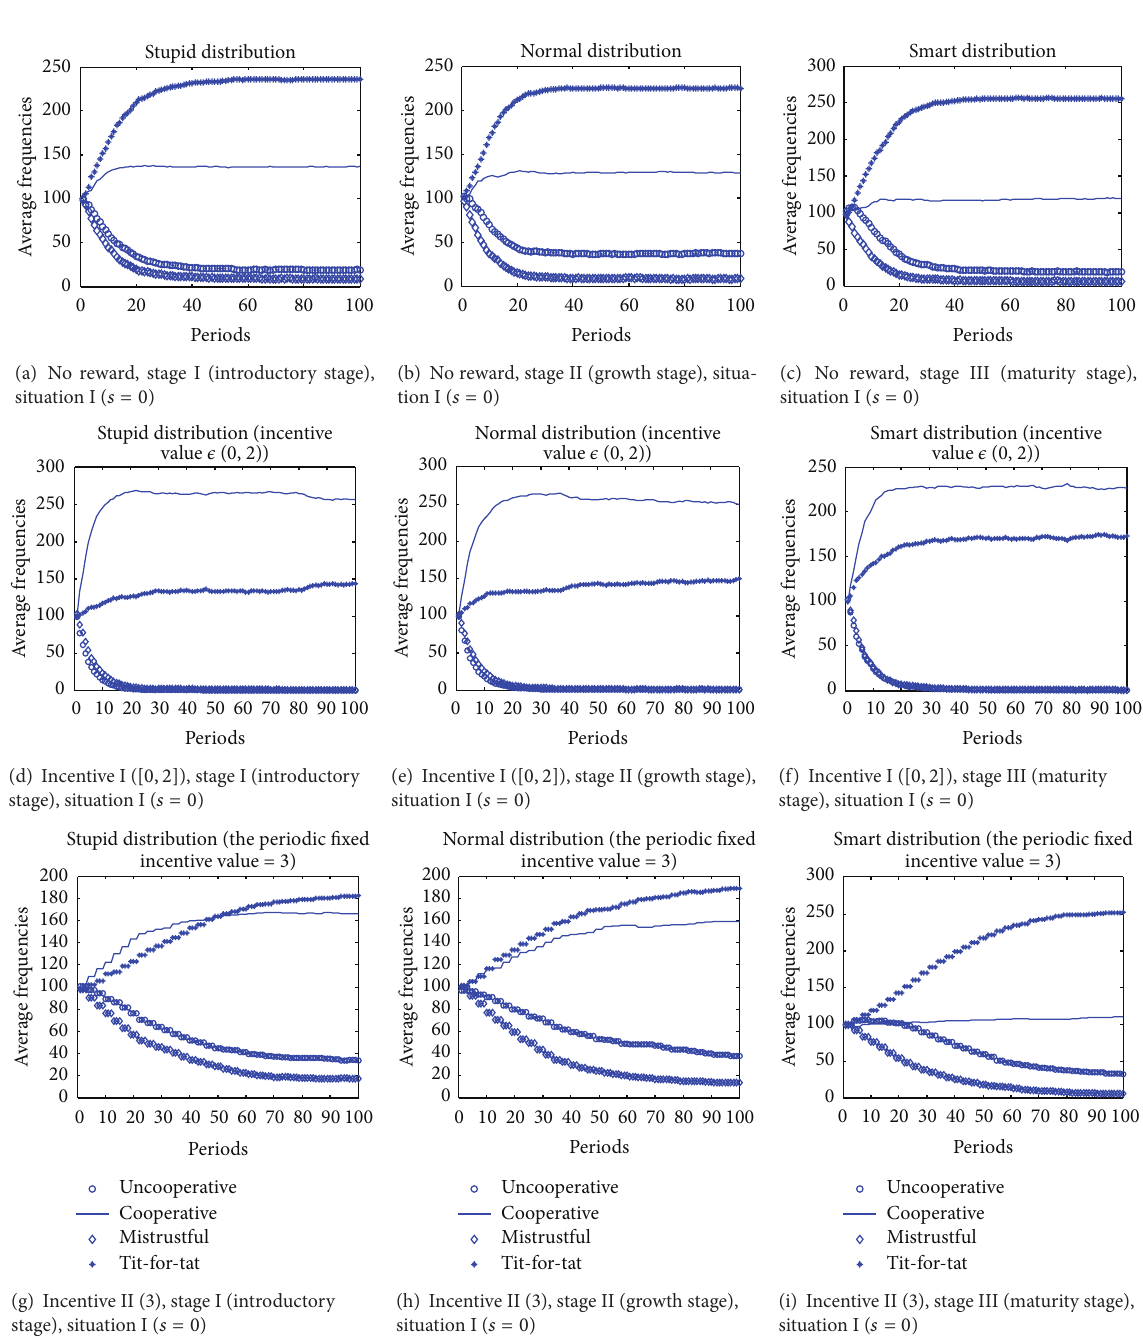
Figure 1: Dynamics about agents’ strategy change in different stages in situation I of